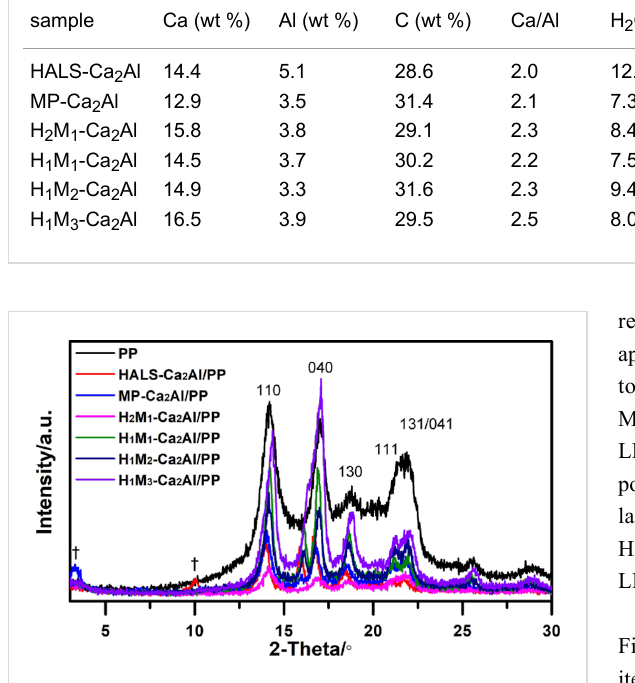
Table 2: Chemical composition of H n M n ′ -Ca 2 Al-LDH samples. sample